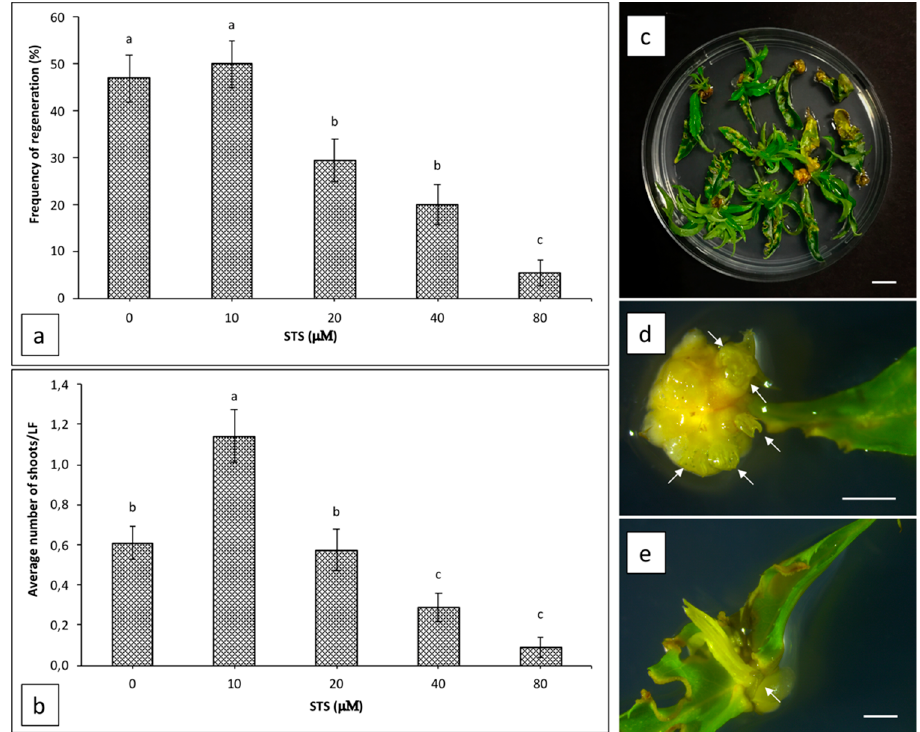
Figure 1. Regeneration e ffi ciency of Hansen 536 leaf explants cultured on WPM 11 supplemented with di ff erent concentrations of silver thiosulphate (STS): ( a ) frequency of regeneration expressed as the number of explants regenerating at least one shoot per total explants treated × 100 and ( b ) the average number of regenerating shoots per leaf (LF) after five weeks of culture. One-way ANOVA was used to analyse the results. Di ff erent letters show significant di ff erences at p < 0.05 by the Newman–Keuls test ± SE ( n = 150). Each value represents the mean ± SE of three independent experiments. ( c ) Adventitious shoots regenerating from leaf explants after seven weeks of culture on WPM 11 supplemented with 10 µ M STS (bar = 1 cm). Adventitious shoots regenerating from petiole ( d ) and from cuts perpendicular to the leaf mid vein ( e ) of Hansen 536 leaves after three weeks of culture on WPM 11 supplemented with 10 µ M STS (bar = 2 mm). White arrows indicate regenerating adventitious shoots.